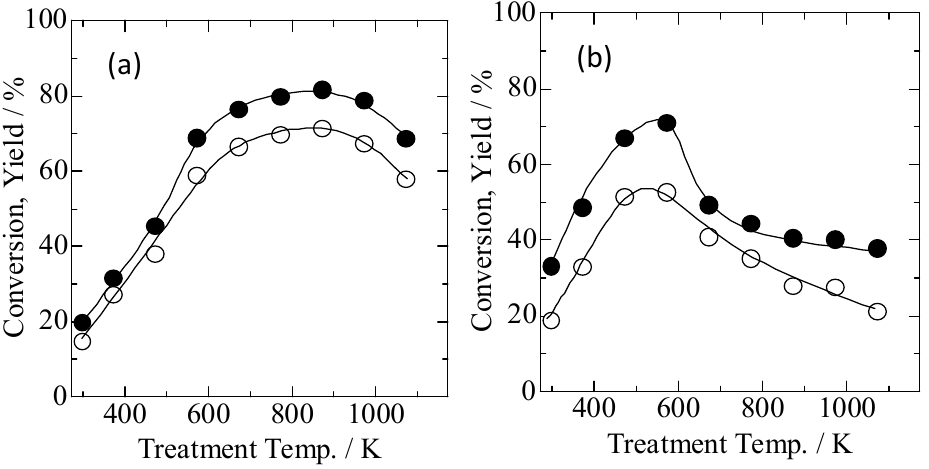
Figure 9. Dependence of conversion and yield of benzaldehyde on calcination temperature of ( a ) 3 wt%-Au/USY zeolite and ( b ) 3 wt%-Au/TiO 2 treated in a stream of 6% H 2 dilute with Ar. Closed symbol: benzyl alcohol conversion; Open symbol: benzaldehyde yield.